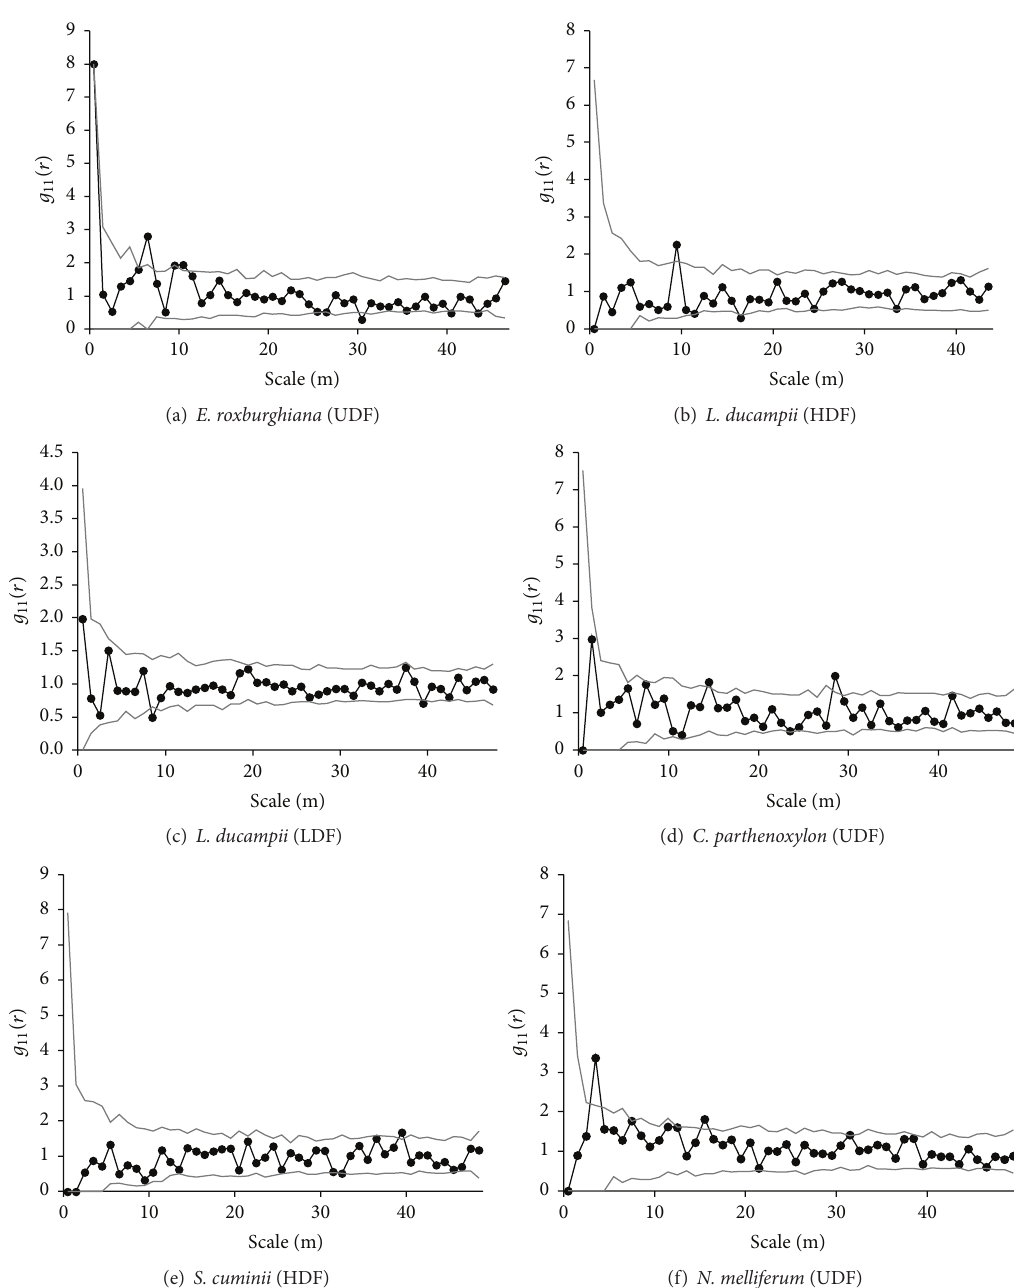
Figure 5: Spatial patterns of the five most abundant tree species shown by the pair-correlation function 𝑔(𝑟) with the null model of CSR. Black lines are observed patterns and grey lines are approximate 95% confidence